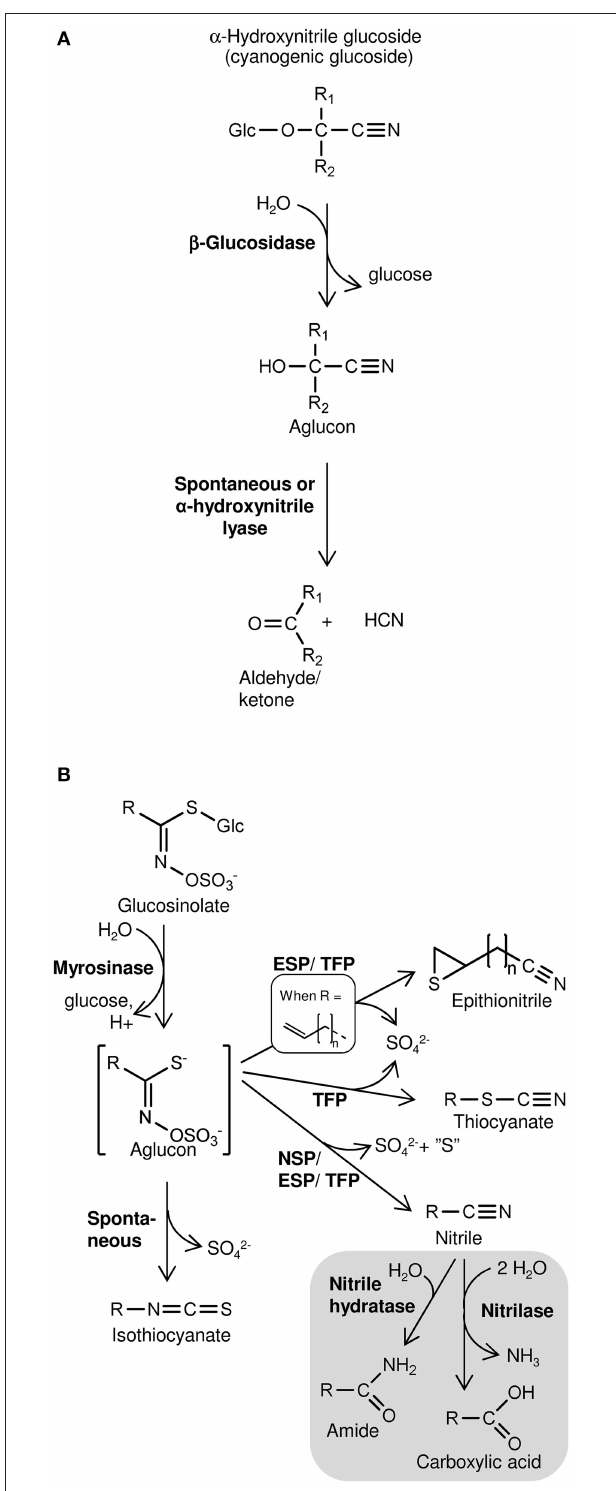
FIGURE 1 | Schematic overview of hydrolysis of cyanogenic glucosides (A) and glucosinolates (B) and subsequent product formation. (A) Cyanogenic glucosides ( α -hydroxynitrile glucosides) release